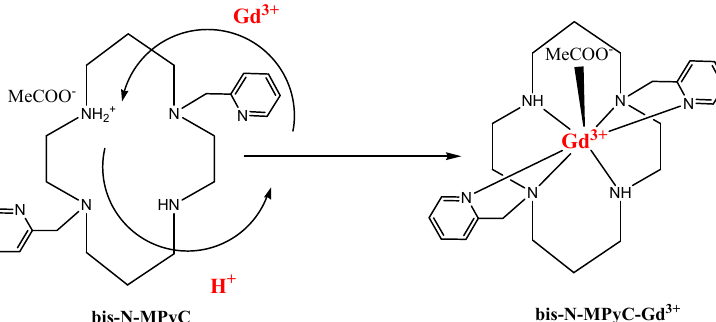
Figure 8. Proposed Gd 3+ complexing process with functionalized cyclam ligands. The coordination of Gd 3+ ion with -N- is shown by the shift of the δ (NH: secondary amines) from 1668 to 1673 cm − 1 (Figure 9). Moreover, the intensity of this band was decreased due to the decrease of the number of N-H bonds. In comparison, the ν (CH sp3: -CH2-group) of the cyclam macrocycle at 2928 cm − 1 was not shifted and remained constant.